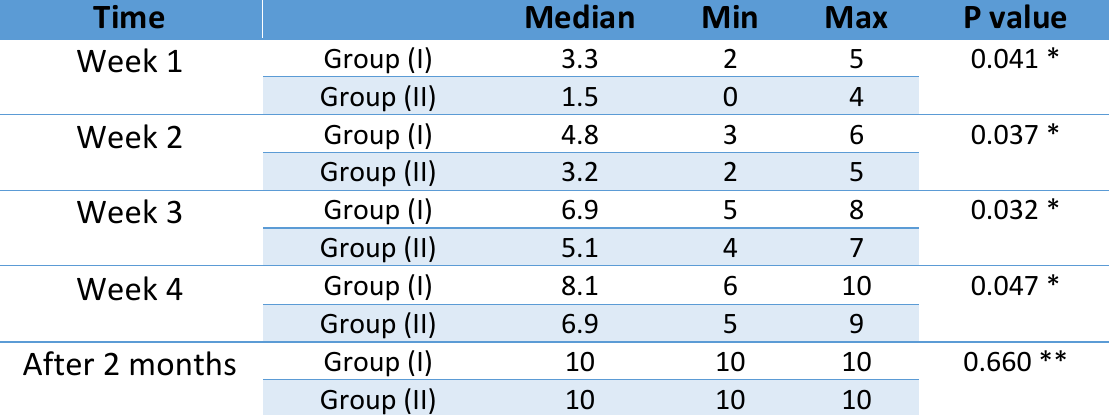
Table 4. Median and range values of color match measured by the Visual Analogue Scale score.